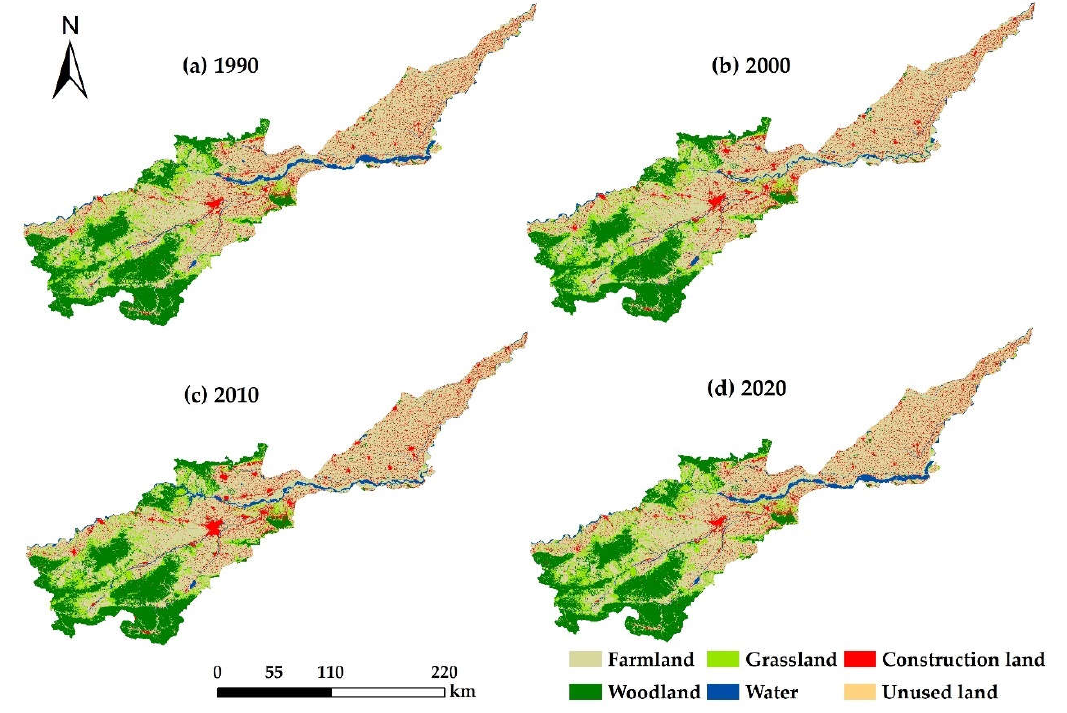
Figure 2. Distribution of land use in the Yellow River Basin (Henan section): ( a ) land use map for 1990; ( b ) land use map for 2000; ( c ) land use map for 2010; ( d ) land use map for 2020. Table 2. Area (km 2 ) and ratio (%) of land use types in the Yellow River Basin (Henan section) from 1990 to